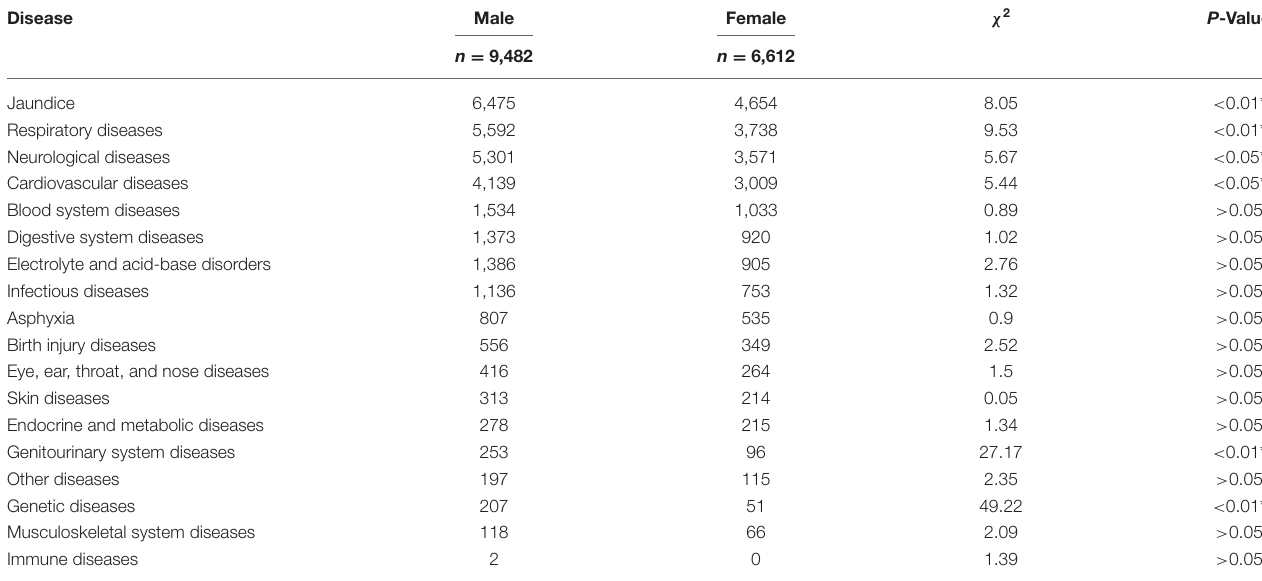
TABLE 8 | Prevalence of neonatal diseases in relation to gender. Disease